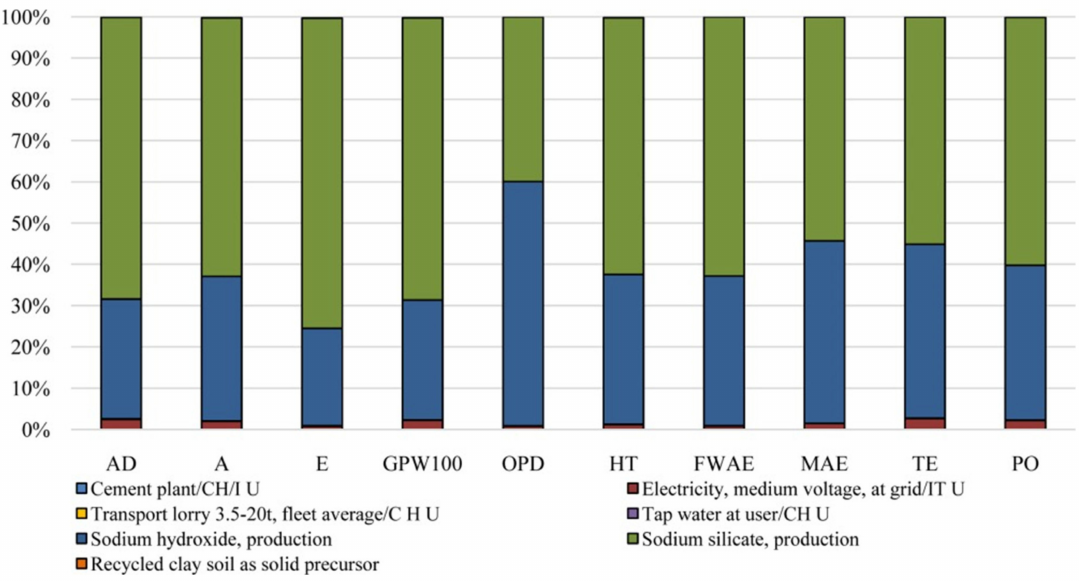
Figure 19. CML characterization values of 1212 kg of geopolymeric binder (AD: abiotic depletion; A: acidification; E: eutrophication; FWAE: fresh water aquatic ecotox; GWP: global warming potential; HT: human toxicity; MAE: marine aquatic ecotoxicity; ODP: ozone layer depletion; PO: photochemical oxidation; TE: terrestrial ecotoxicity). Reprinted from [85], © 2020 with permission from